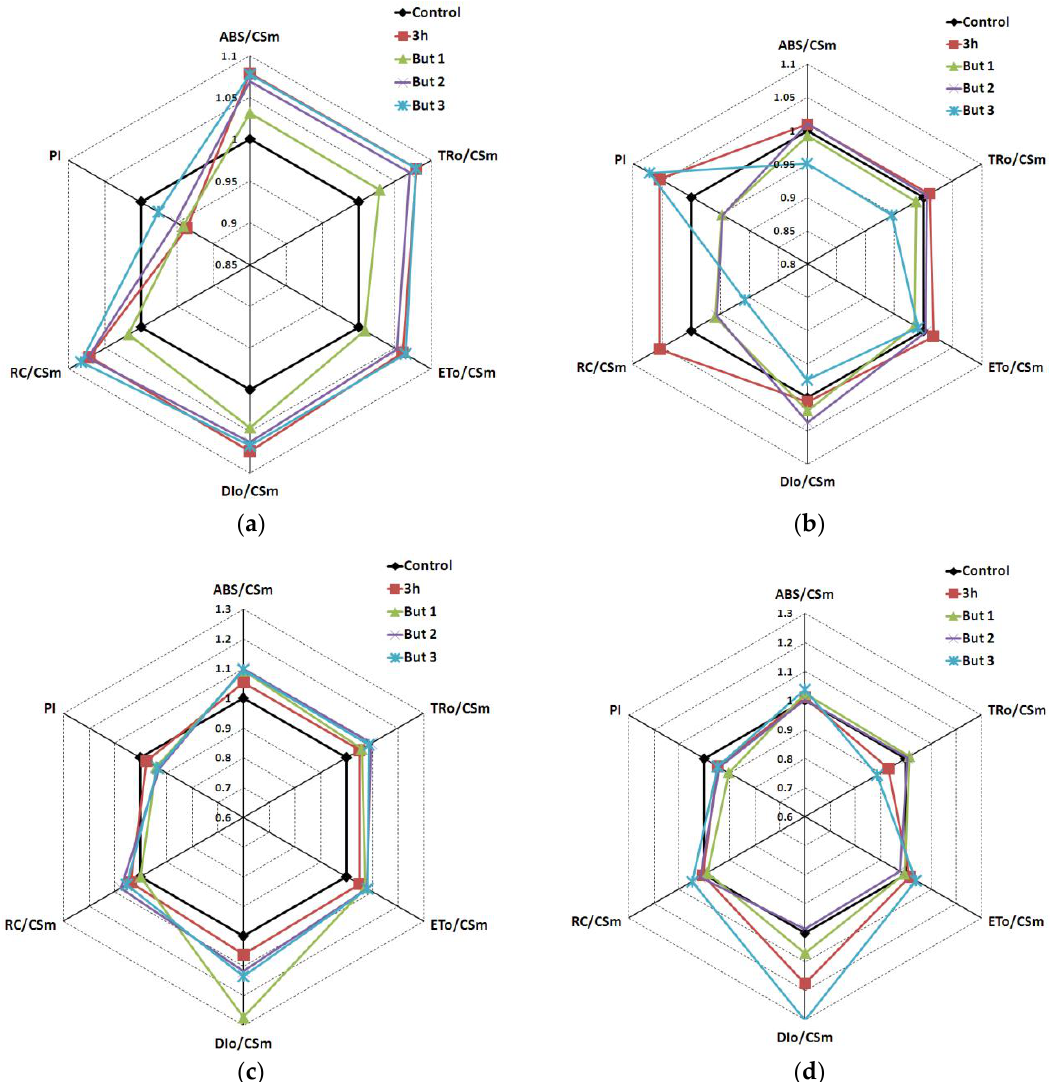
Figure 10. Radar plot of chlorophyll a fluorescence kinetics parameters of two L. angustifolius cultivars germinated and grown for the first four weeks at 7 °C (Lazur — ( a ); Sethes Fruehe Rote — ( b )) or 13 °C (Lazur — ( c ); Sethes Fruehe Rote — ( d )). Control — plants grown from seeds germinated in water; 3 h — plants grown from seeds hydroprimed for 3 h at 20 °C; But 1, But 2, But 3 — plants grown form seeds germinated in the presence of 10 −6 , 10 −5 and 10 −4 M butenolide, respectively. Black line indicates to control plants as 100%. Values represent means ( n = 10).